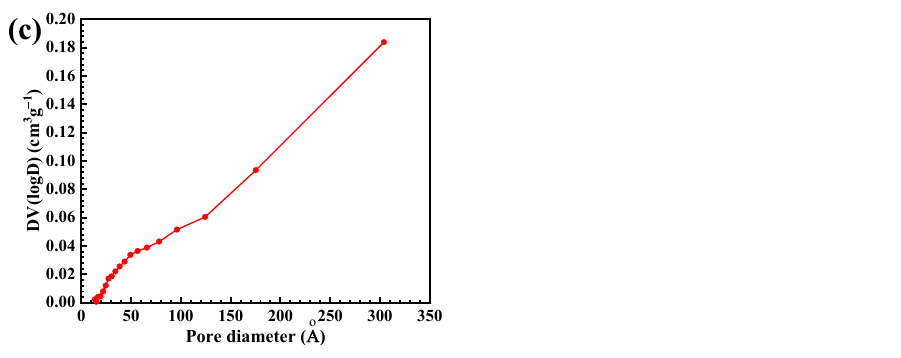
Figure 5. TG thermogram ( a ), N 2 adsorption − desorption isotherm ( b ), and pore size distribution curve ( c ) of the CdS.